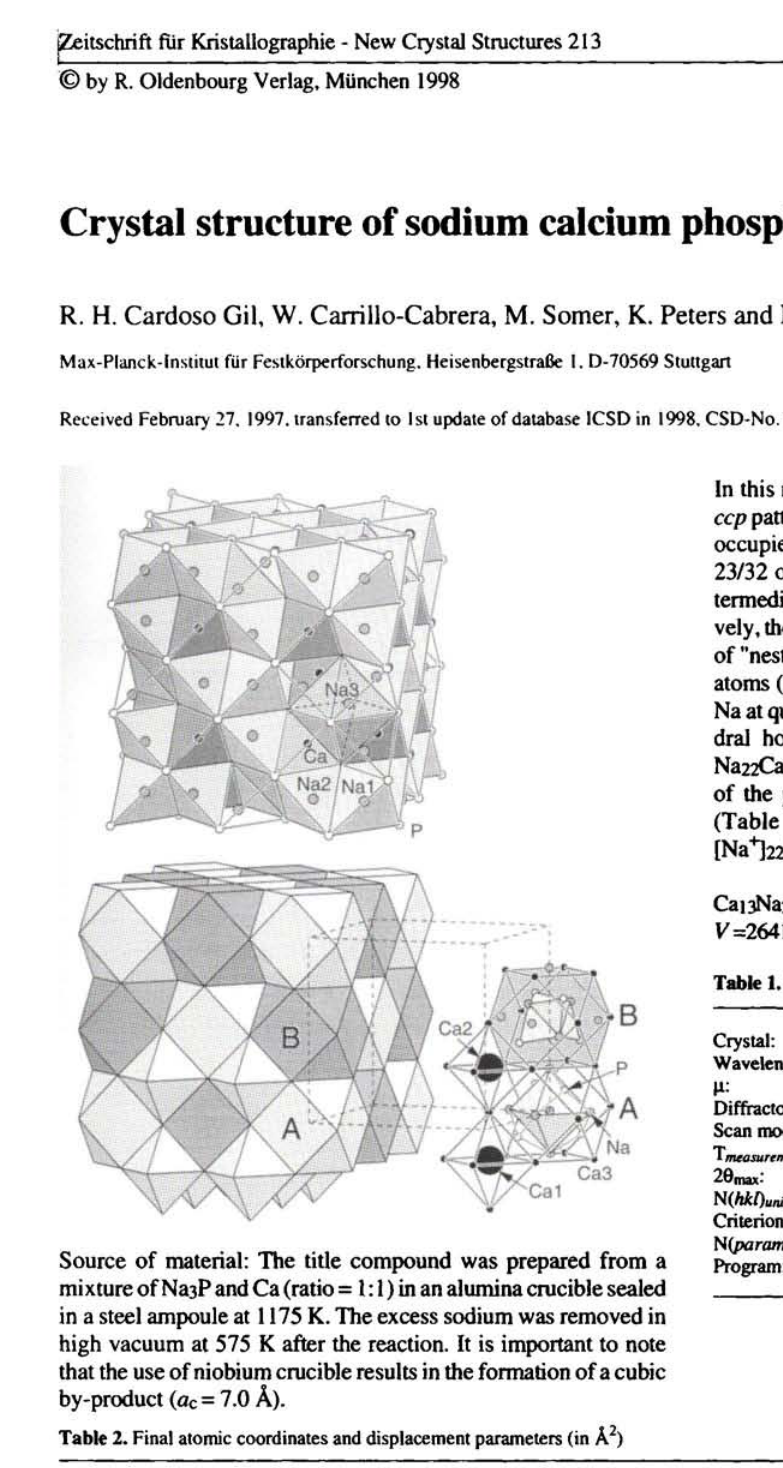
Table 2. Final atomic coordinates and displacement parameters (in Â^)